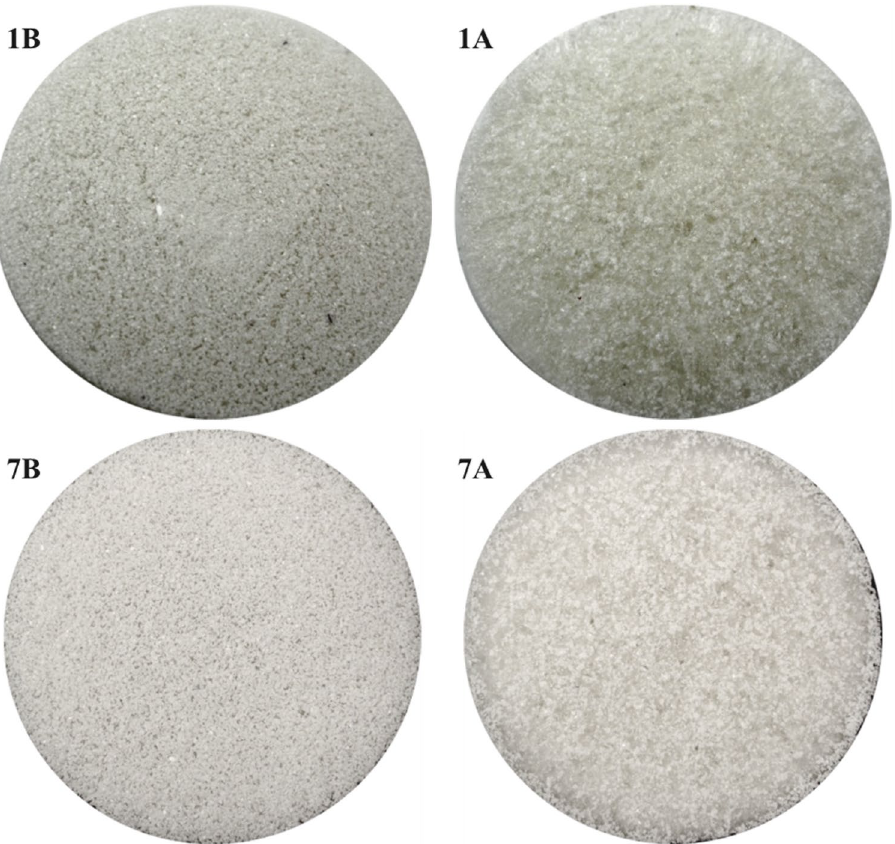
Figure 6. Pictures of sides B and A of sample 1 (without glycerol) and sample 7 (3.2 ml glycerol).